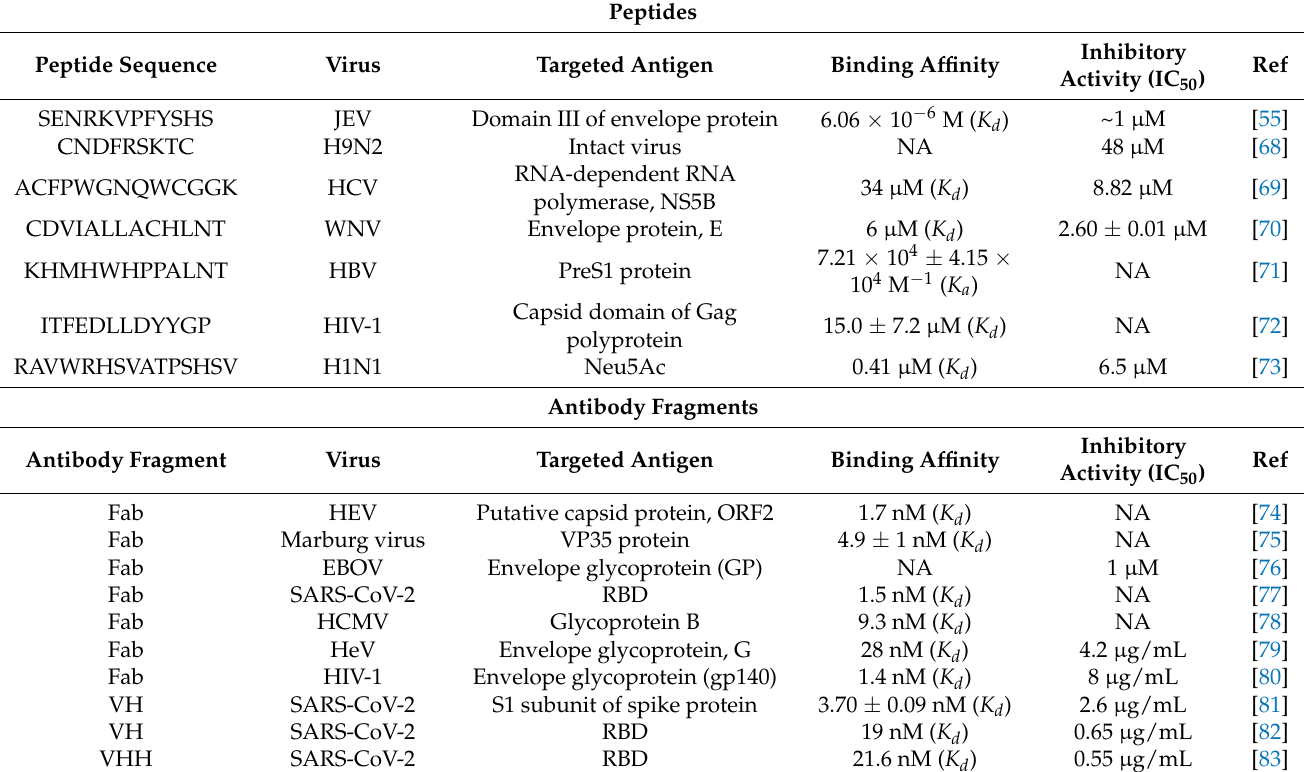
Table 1. A list of selected phage display-derived